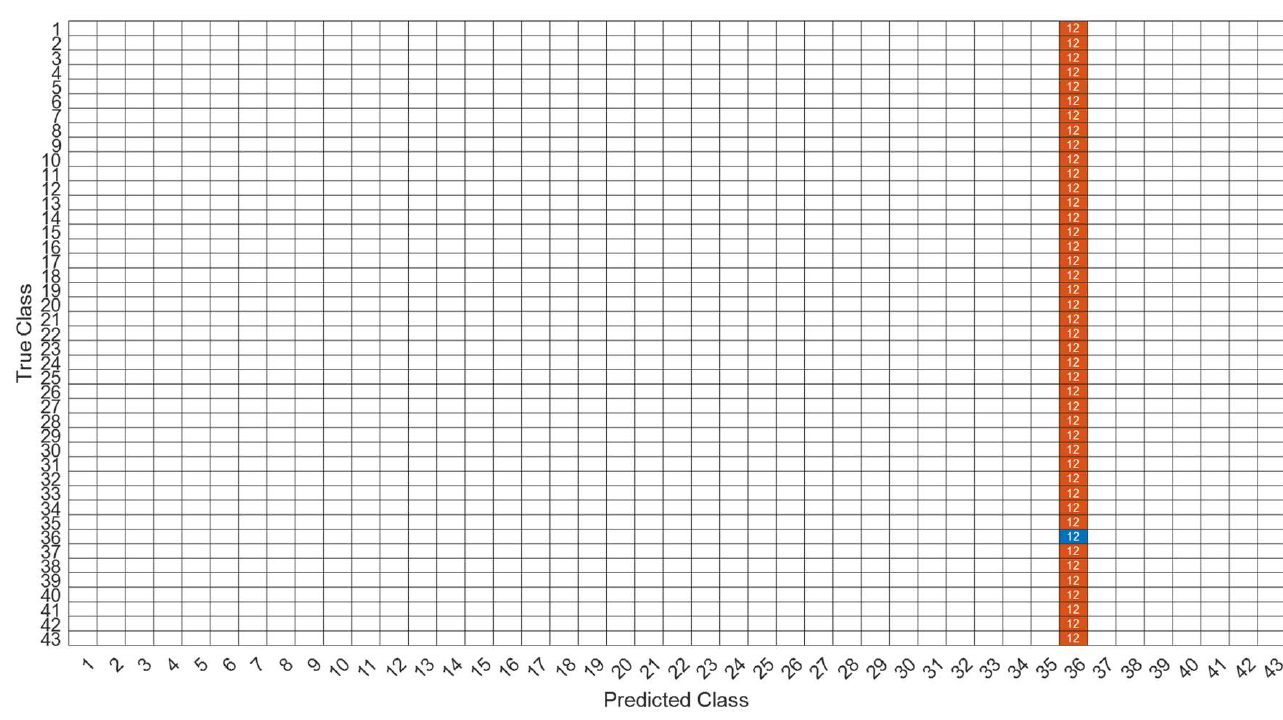
Figure 30. The confusion matrix of the LSTM model with LPC 40-features dataset.